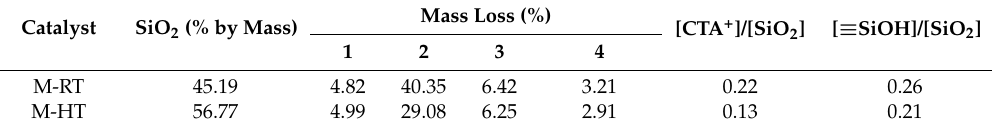
Figure 7. ( a ) DTG (derivative of mass) curves; ( b ) thermograms of the as-synthesized silicas. The different regions indicated correspond to (1) water desorption, (2) surfactant degradation by Hoffman reactions, (3) degradation of residual products, and (4) condensation of silanol groups. Table 3. Mass loss calculations for regions (1), (2), (3), and (4), and contents of CTA + groups in the [CTA]-MCM-41 hybrid silicas.